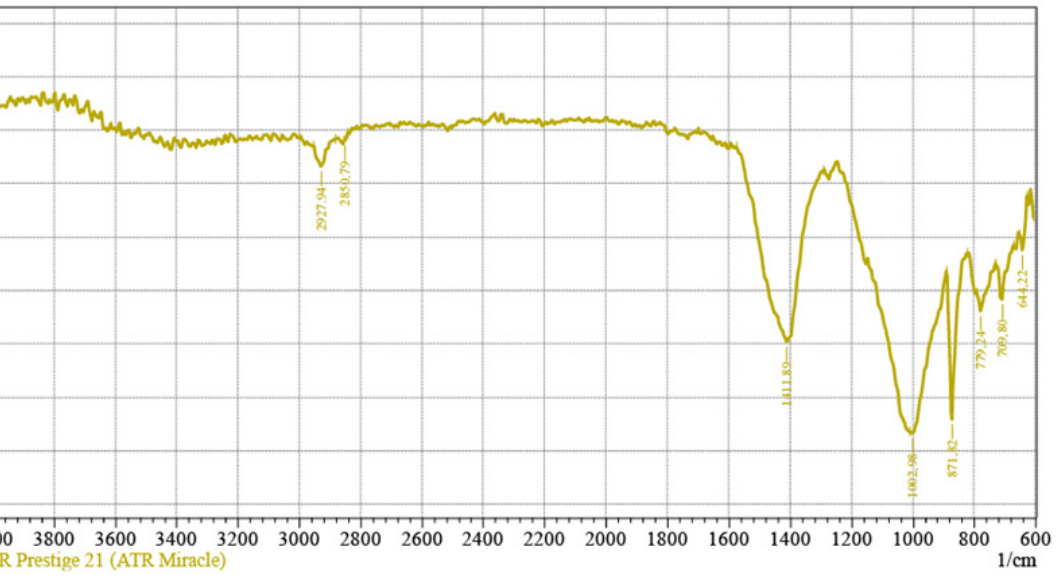
Figure 9. FTIR pattern of the cement paste based on the binder “thermally treated marl (700 °C)—alkaline solution” (sample TM1).